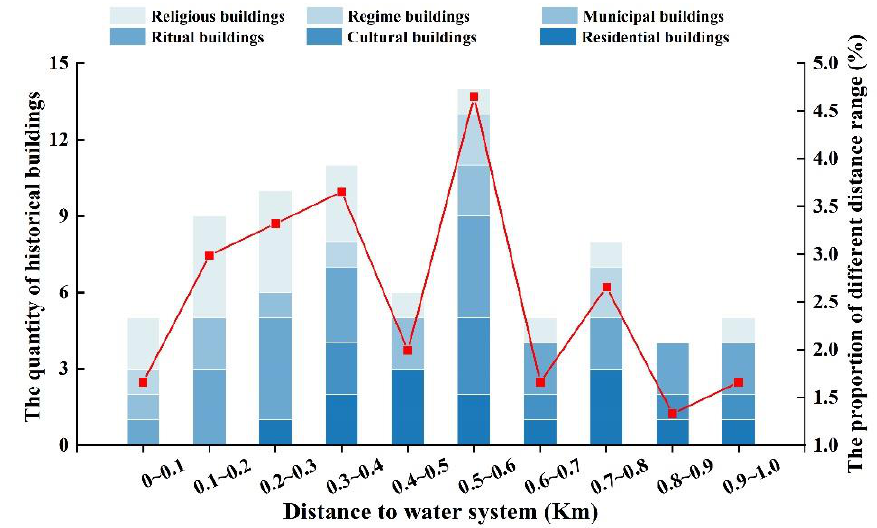
Figure 14. Quantity of each type of historical building distributed at different distances from the water system ( ≤ 1000 m).